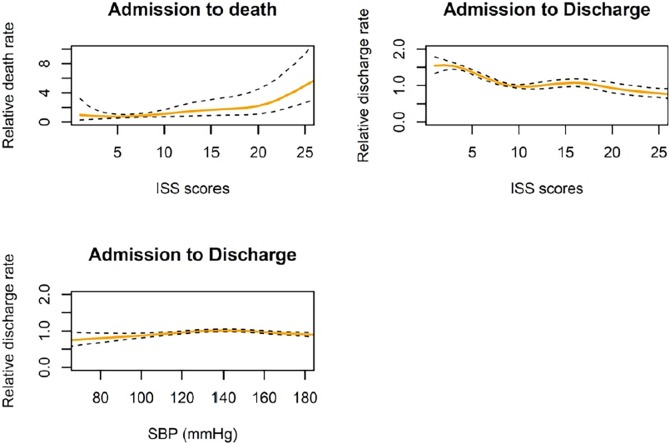
Non-linear effects of injury severity scores on transition-to-death and transition-to-discharge, and non-linear effects of systolic blood pressure on transition-to-discharge.When the ISS reached above 20, the risk for transition-to-death increased exponentially. The p-value of penalized spline for linear effect of ISS score is <0.001, while p-value of penalized spline for non-linear effect of ISS score is 0.018. In the transition-to-discharge, ISS had a linear effect on discharge when ISS<10. The p-value for linear effect of ISS score is <0.001 as well as the nonlinear effect. Lower and higher systolic blood pressure had lower potential for transition-to-discharge. The p-value for linear effect of systolic blood pressure is 0.450, while p-value of for non-linear effect is 0.001. The reference level of injury severity score was 9, while reference level of systolic blood pressure was 150 mmHg.